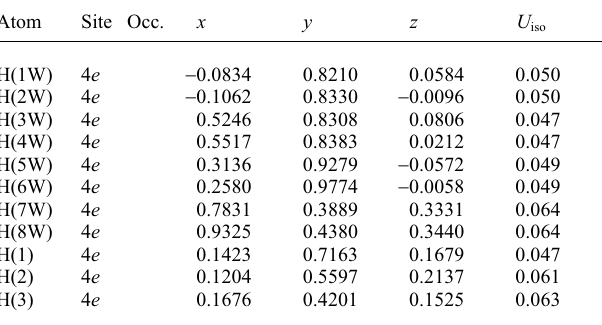
Table 2. Atomic coordinates and displacement parameters (in Å 2 ) . Atom Site